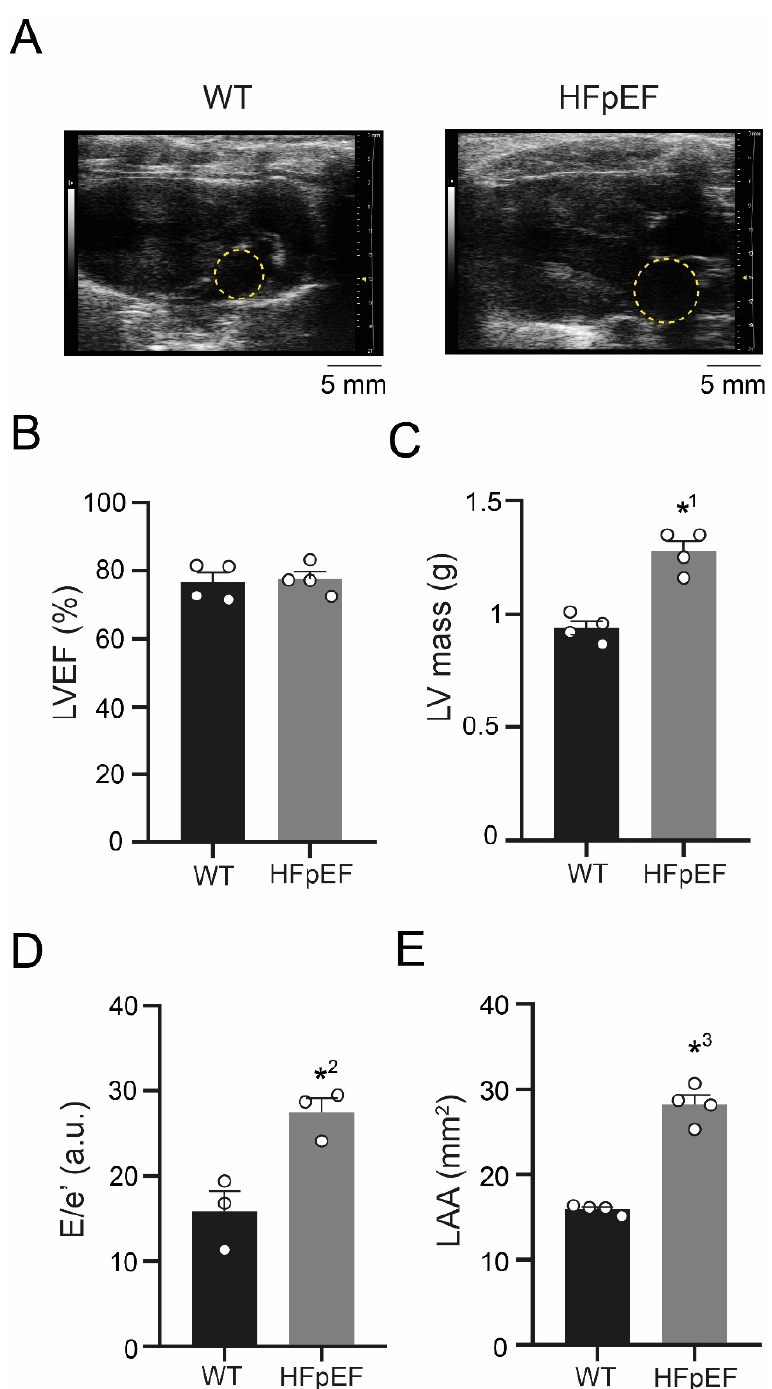
Figure 1. ( A ) Representative example of transthoracic echocardiographic assessment (B-mode) in parasternal long axis view of WT (left) and HFpEF (right) during diastole, yellow circles indicate left atria. ( B ) Corresponding left ventricular ejection fraction and ( C ) left ventricular mass (weighed). ( D ) E / e’ as a measure of diastolic dysfunction (derived from mitral valve flow and tissue Doppler). ( E ) Left atrial area. Statistical analysis: Student’s t -test. p -values: * 1 0.0008, * 2 0.016, * 3 < 0.0001. n -numbers indicate animals.